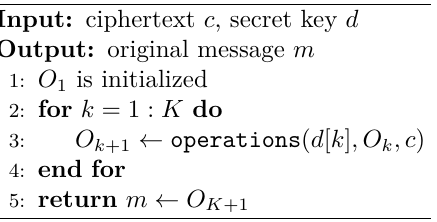
Algorithm 1 Target algorithm (decryp- tion function)